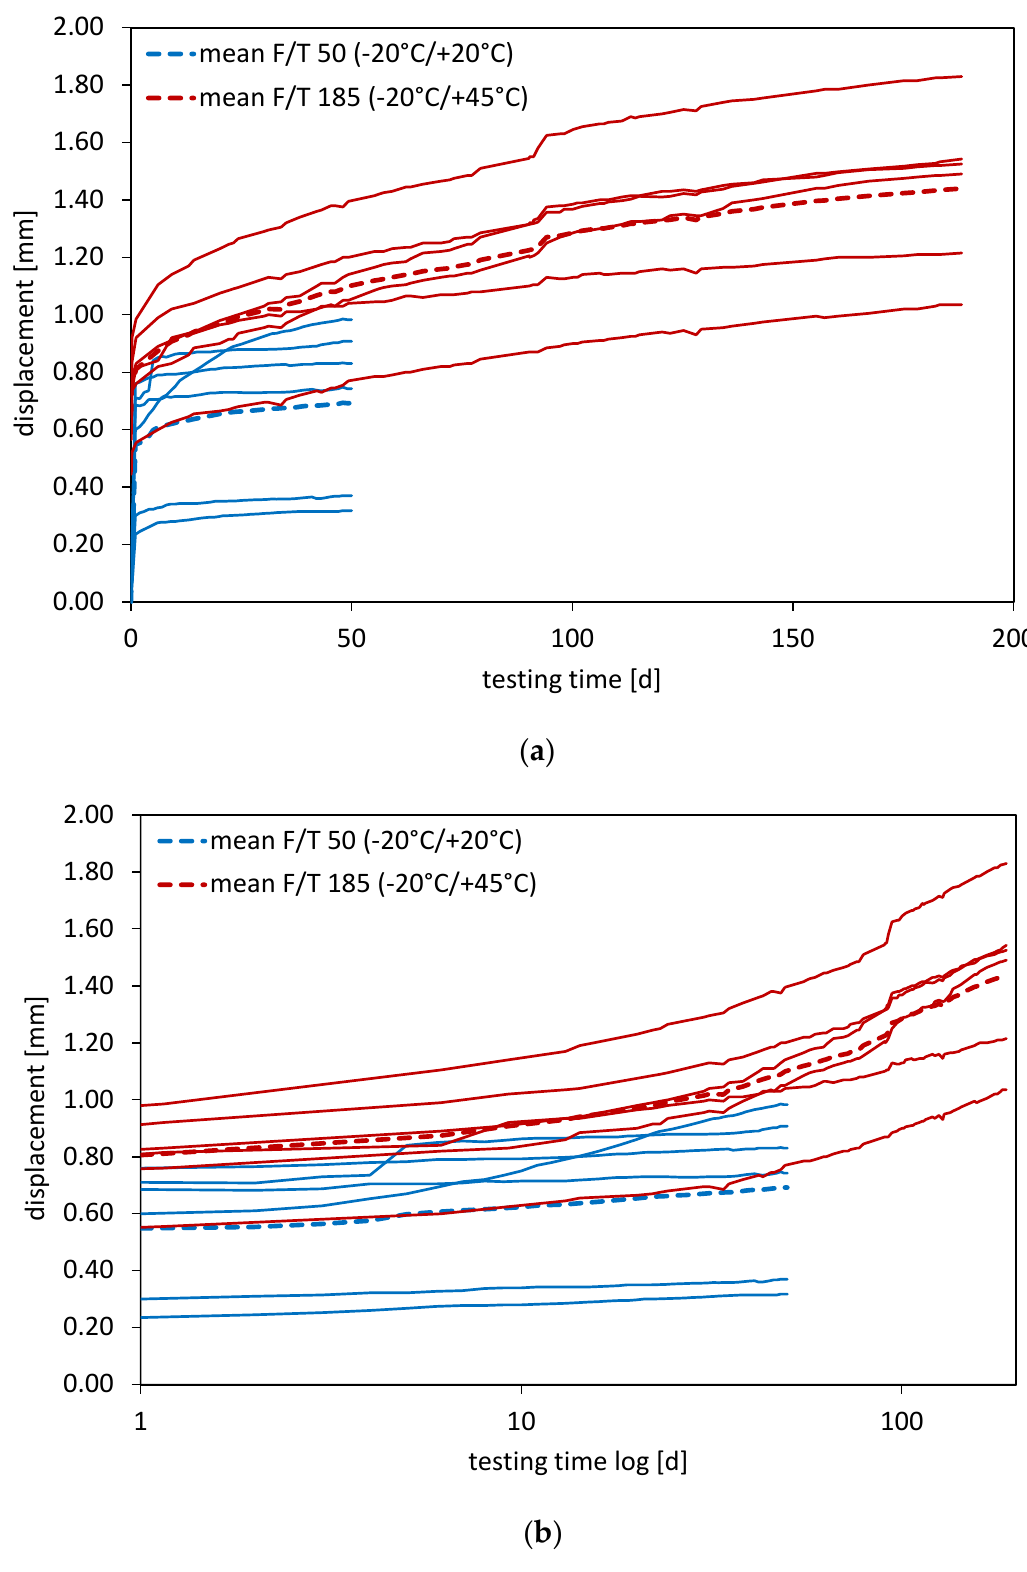
Figure 7. ( a ) Measured displacements during the 50 freeze-thaw cycles between −20 °C and +20 °C